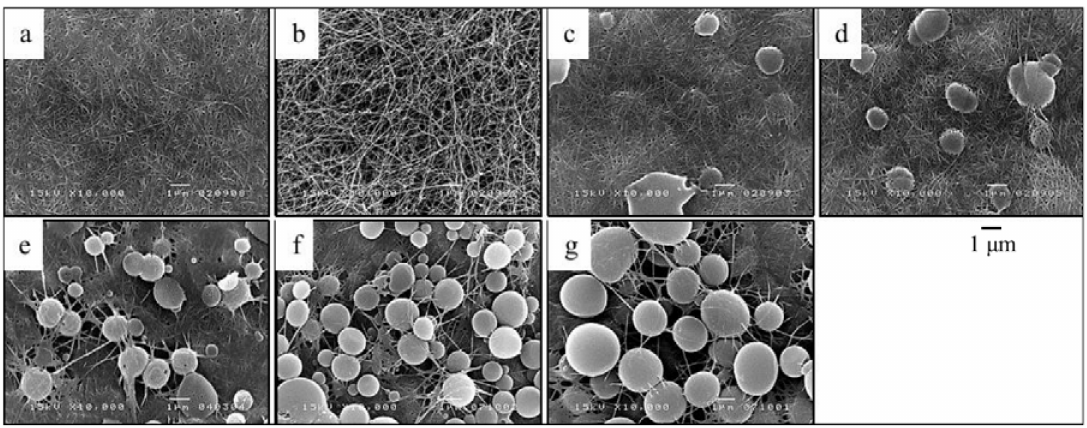
Figure 1. SEM images of surface morphology of a dried BC film ( a ), a rehydrated BC film ( b ), and dried films of BCC0.2 ( c ), BCC0.4 ( d ), BCC0.6 ( e ), BCC0.8 ( f ), and BCC1.0 ( g ) at the magnification of 10,000 ×